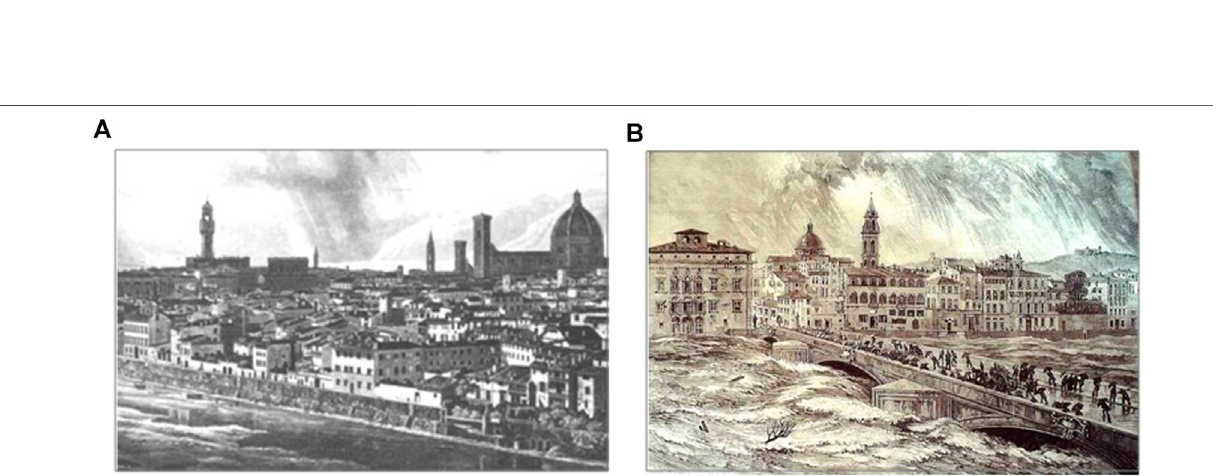
Frontiers in Earth Science |